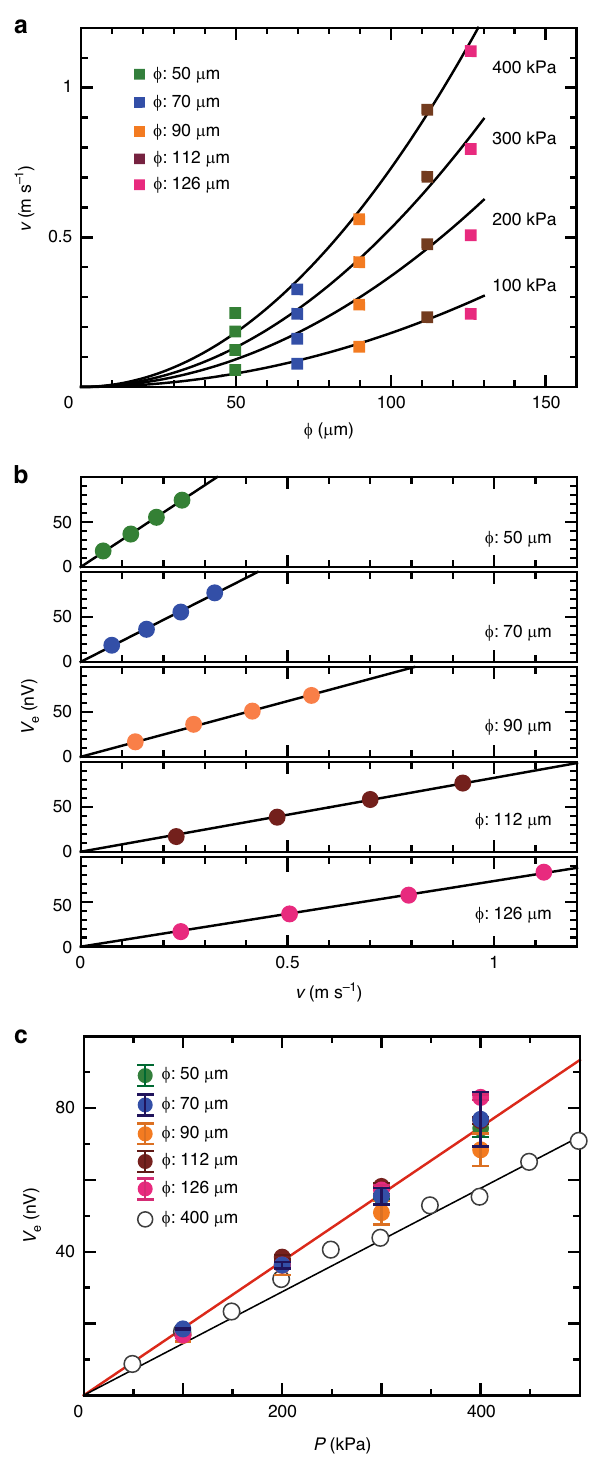
proportional to v in a laminar fl ow, being consistent with the experimental result shown in Fig. 2e.